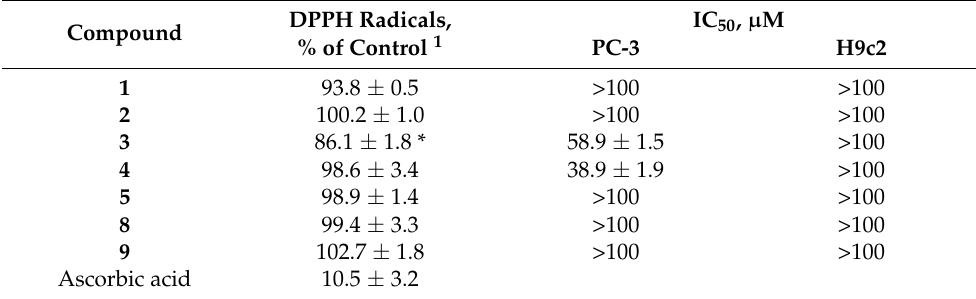
Table 3. DPPH radical scavenging and cytotoxic activities of compounds 1–5 , 8 , and 9